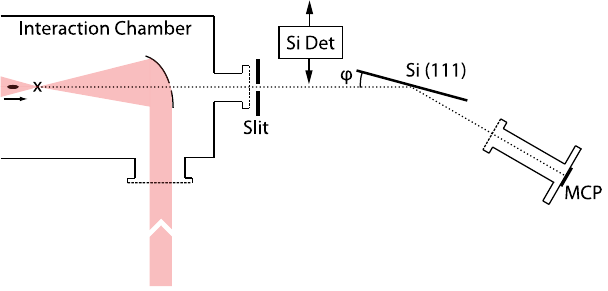
FIG. 1. Experimental setup of the ICS source at the BNL ATF. The x rays (dotted line) are generated at the IP (X), collimated by the metal slits, and are then reflected off the silicon crystal, Si (111), for detection at the MCP. A retractable silicon detector (Si Det) is used for total flux